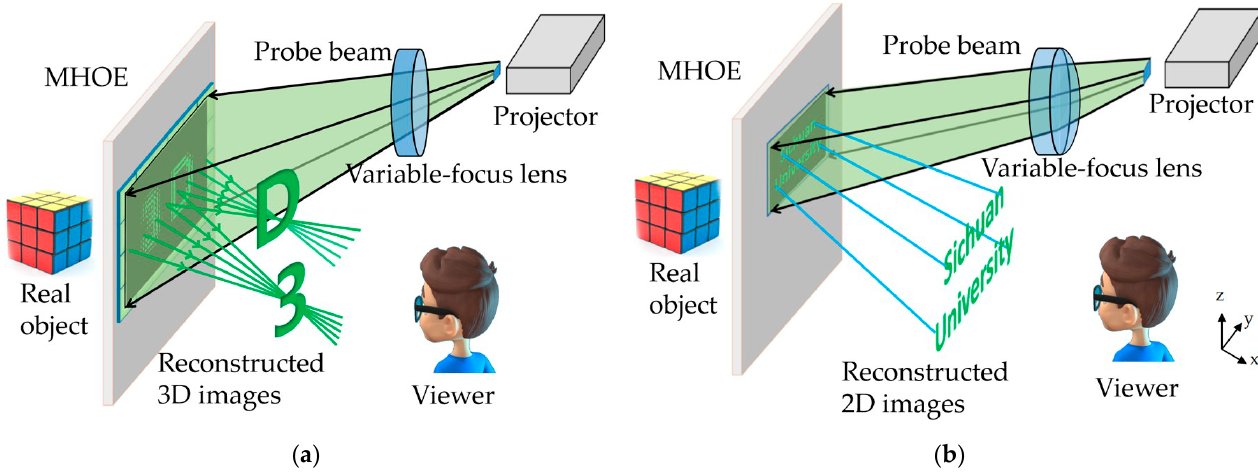
Figure 1. Schematic diagrams of system structure: ( a ) 3D image reconstruction when the probe beam satisfies the Bragg diffraction condition 1; ( b ) 2D image display when the probe beam satisfies the Bragg diffraction condition